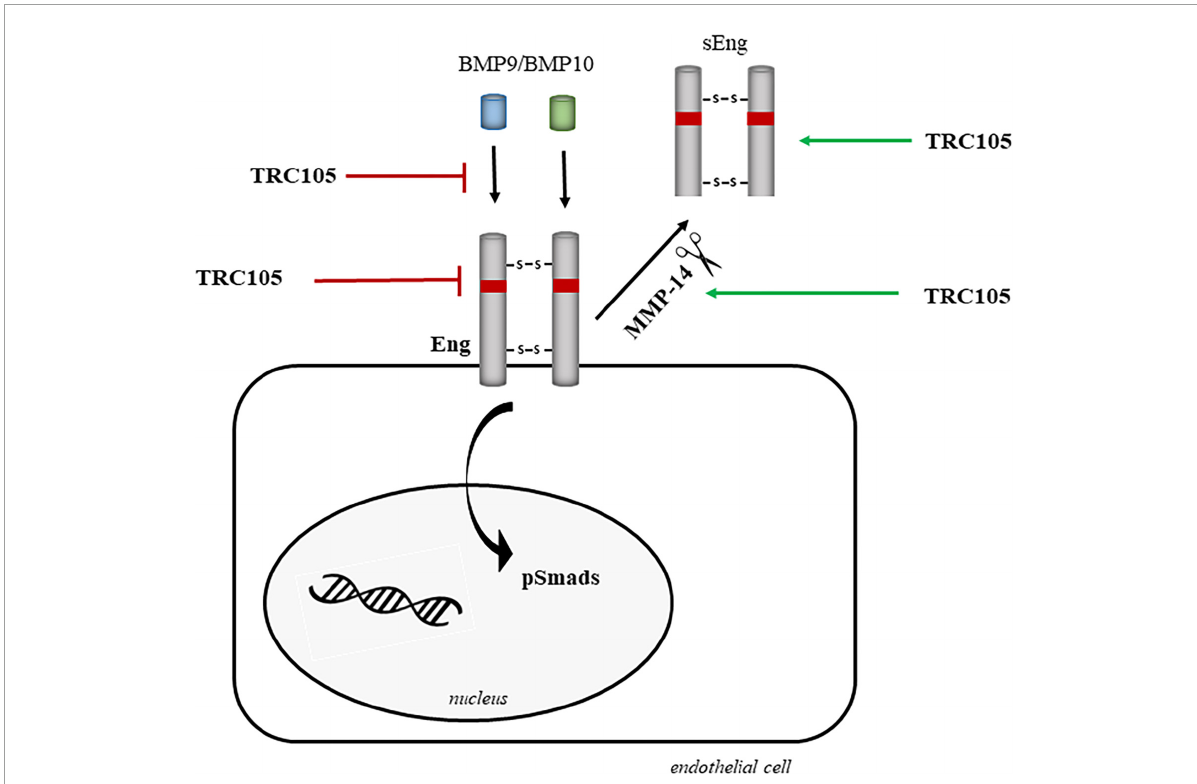
FIGURE11 Hypothetical model of the molecular mechanisms underlying the effects of TRC105 by targeting Eng in human aortic endothelial cells under hypercholesterolemic (treated with 7-ketocholesterol [7K]) or hyperglycemic (treated with high glucose [HG]) conditions. TRC105 can inhibit: (i) the binding of the Eng ligands BMP9 and BMP10 (40); (ii) the expression of membrane-bound Eng; and (iii) the phosphorylation of Smads, which are downstream targets of Eng. TRC105 can also stimulate the protein expression of the metalloproteinase 14 (MMP-14), which in turn cleaves membrane-bound Eng and releases sEng